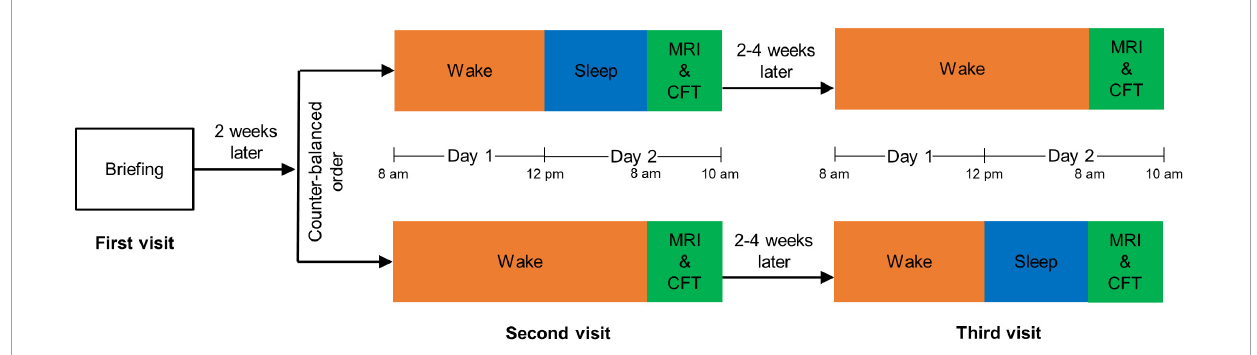
FIGURE1 The flowchart of experimental procedure. MRI, magnetic resonance imaging; CFT, complex figure test.